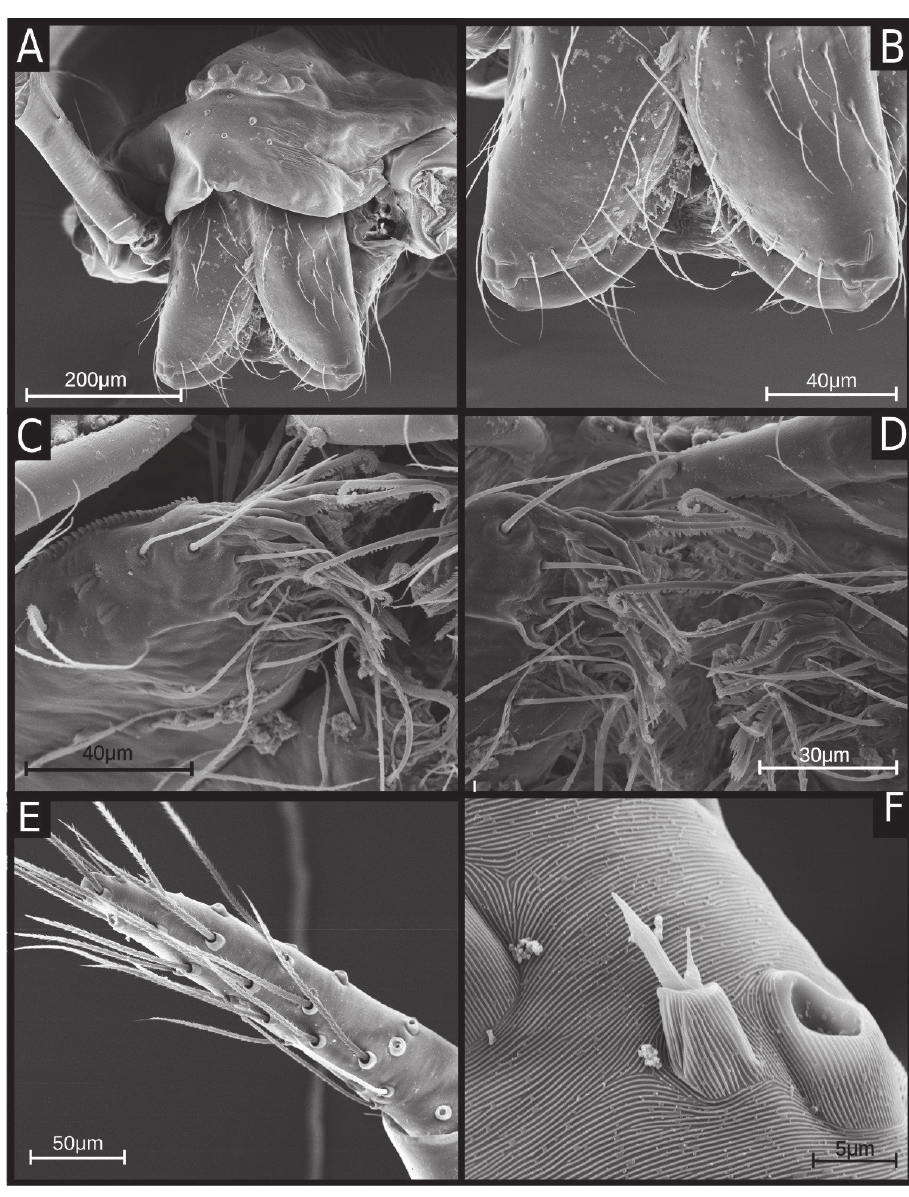
Figure 12. SEM images of Ochyrocera rosinha sp. nov., female (UFLA 60680) A carapace, anterior view B chelicerae, frontal view C endites, ventral view D same, crosier-like macrosetae, detail E pedipalp, distal view F same, tarsal organ,